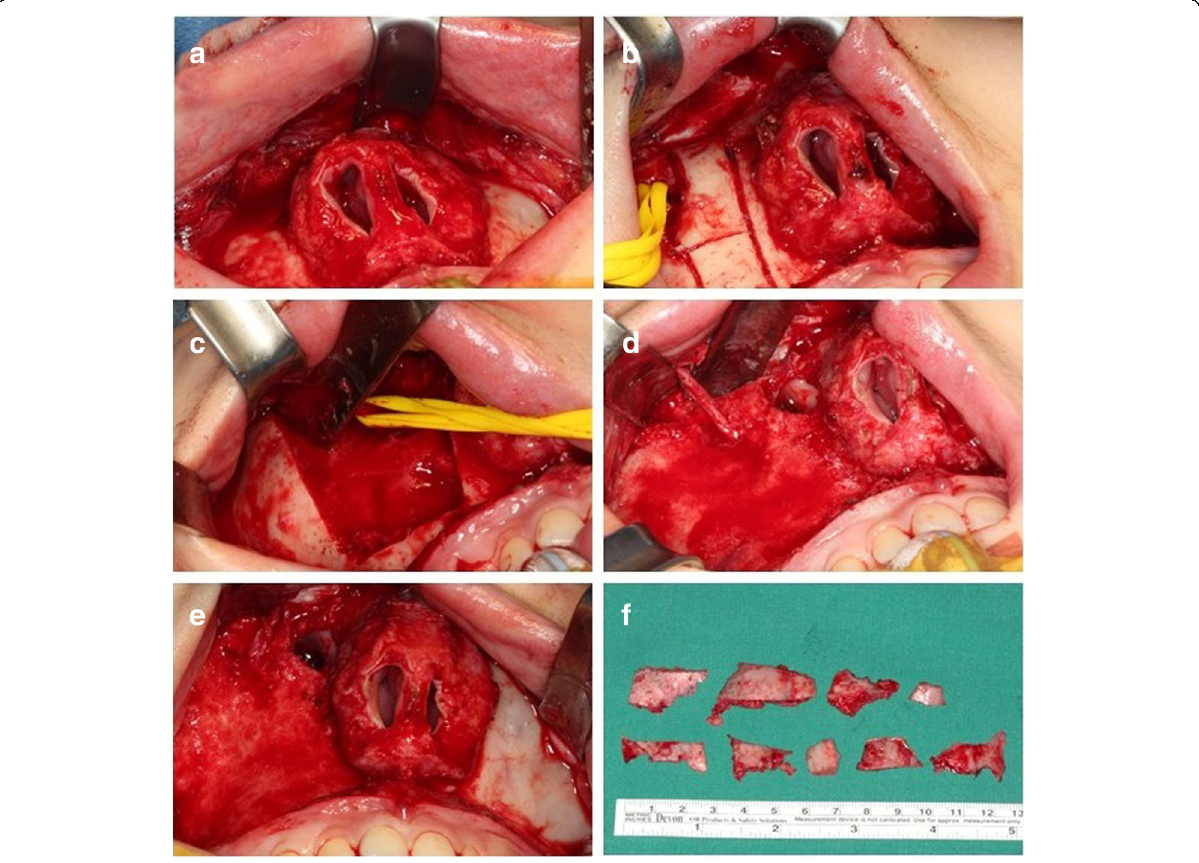
Fig. 5 Intraoperative views of the midfacial degloving approach. a , b Intraoperative view of the midfacial degloving technique showing exposure of the nasal cavity and maxillary area. c , d The bilateral maxillary areas were completely exposed, and the bilateral fibrocystic lesion was removed while preserving the infraorbital nerve. e , f The right maxillary area from which the lesion was removed and the left area were almost